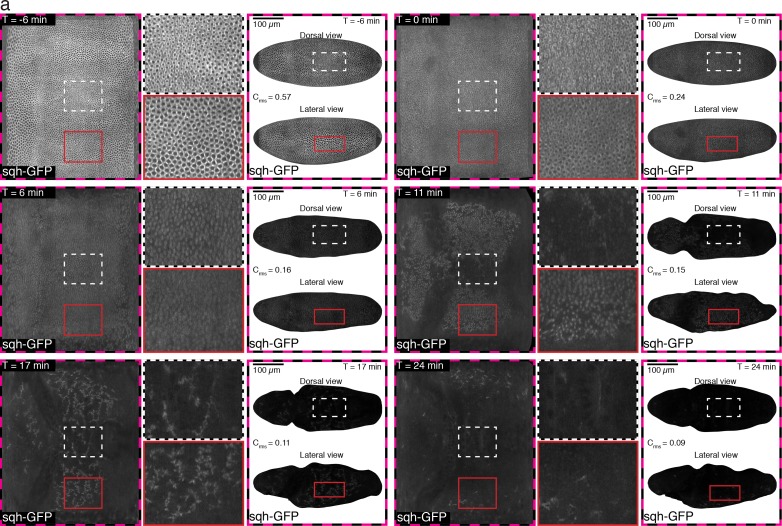
Time course of Myosin on basal surface, as described in Figure 1—figure supplement 1g.Root mean square contrast Crms for across the entire embryo surface is reported for each time point shown. Images have been normalized to range from 0 to 1 as described in the SI.